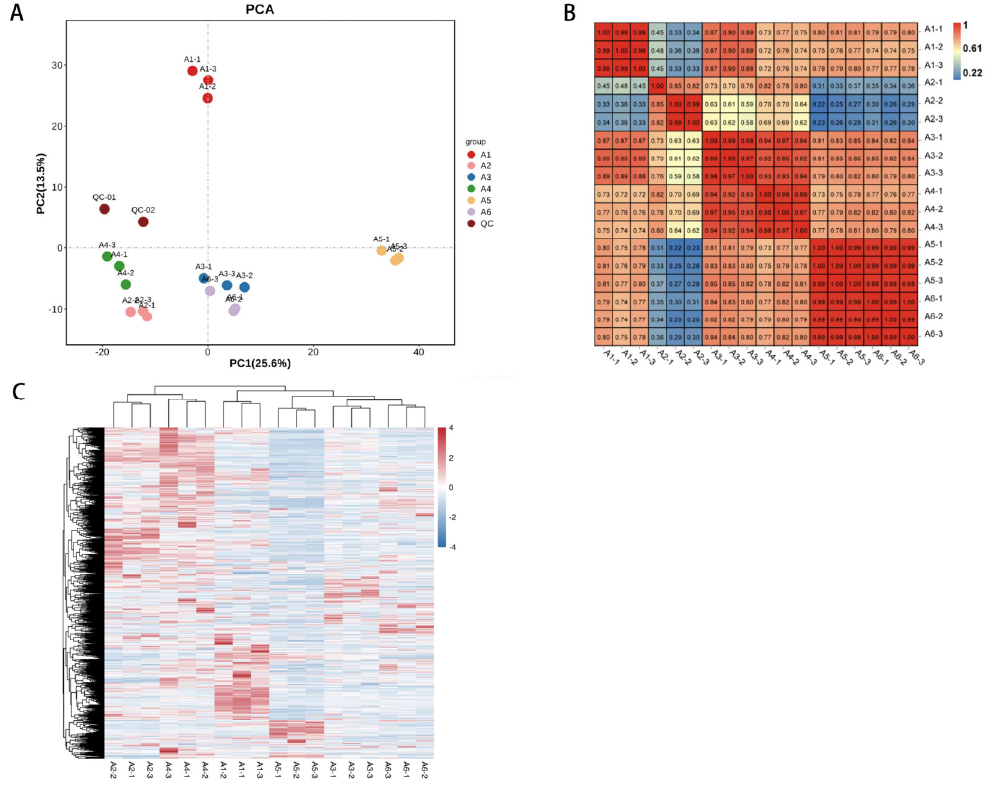
Figure 3. Principal component analysis, heat map analysis, correlation analysis of relative differences in the metabolite content of different varieties of wine. ( A ) Principal component analysis of the metabolites of six samples. Equal wine samples were mixed and used as quality control (QC). ( B ) Cluster heat map analysis of the metabolites of six varieties of wine samples. The colors indicate the accumulation level of each metabolite, with higher values from low (blue) to high (red) and darker colors indicating a stronger correlation between the two samples. ( C ) Cluster heat map analysis of the metabolites of six varieties of wine samples. The colors indicate the accumulation level of each metabolite, with higher values from low (blue) to high (red) and darker colors indicating a stronger correlation between the two